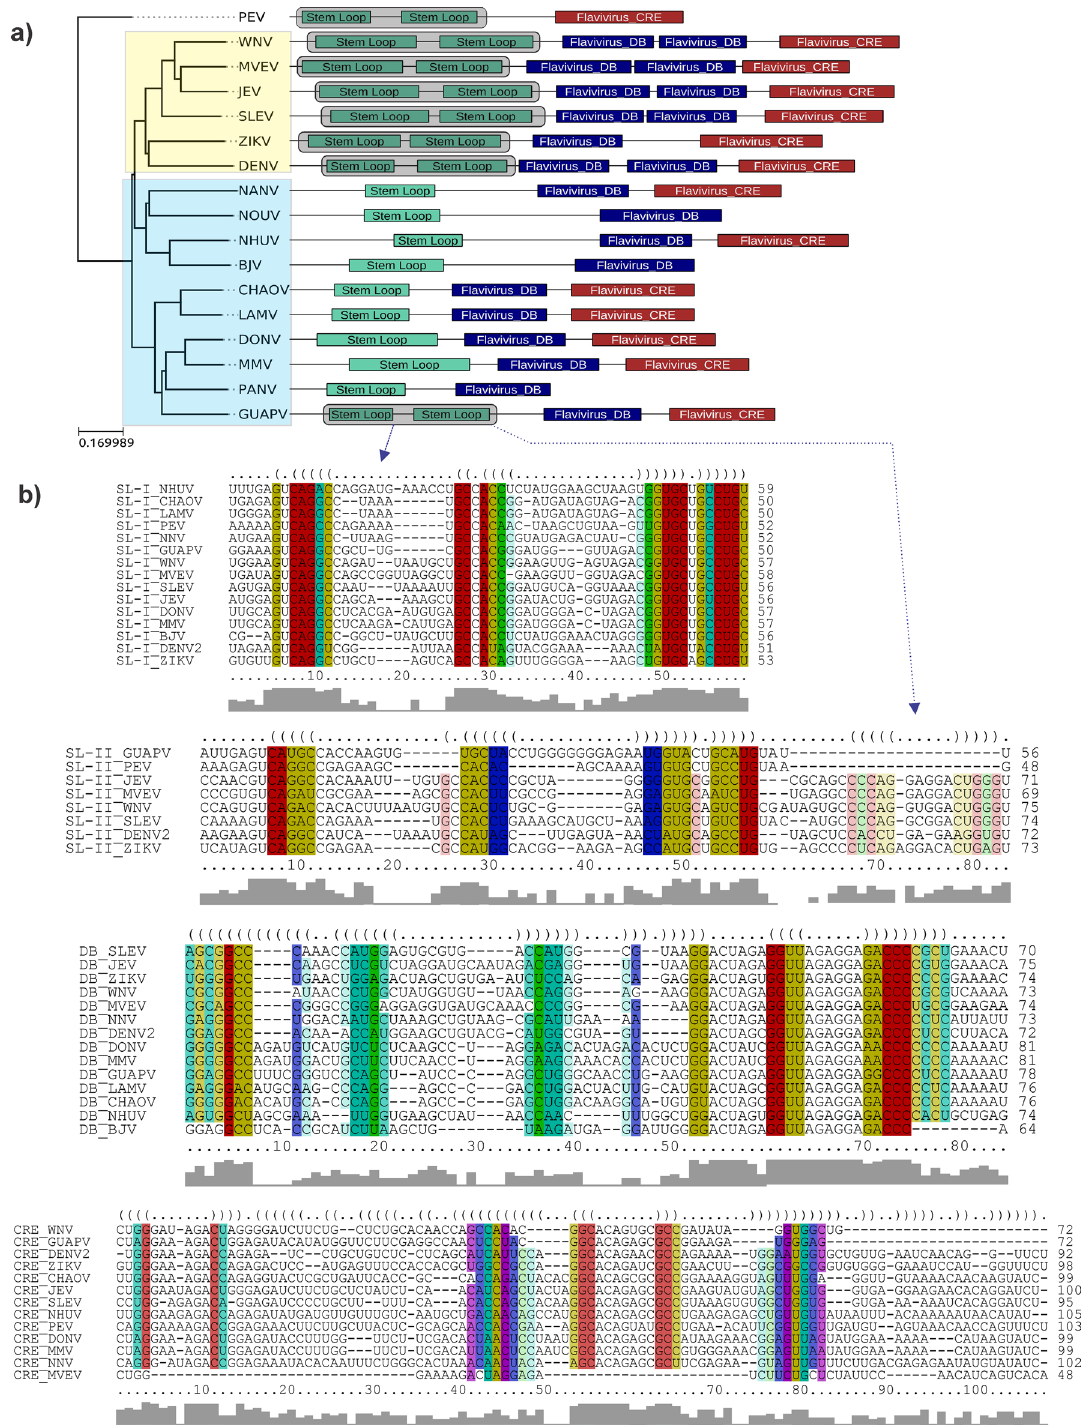
Figure 7. Duplication 3 ′ UTR structures. ( a ) Annotated 3 ′ UTRs of dISFV and MBFV. The phylogenetic tree was constructed using the maximum likelihood method from complete coding sequence nucleotide alignments. MBFV and dISFV strains are highlighted with a yellow box and blue box, respectively. PEV is an outlier. For each species with available 3 ′ UTR sequence, a schematic of the 3 ′ UTR architecture is drawn next to the branches of the tree. Colored boxes represent conserved RNA structural elements identified by CMs, according to implemented in the Infernal package. All boxes correspond to the exact coordinates of annotated structural elements. The gray boxes highlight the duplication of SL in all species in which it occurs. ( b ) Structural alignments of elements of dISFV and MBFV conducted in locRNA 25